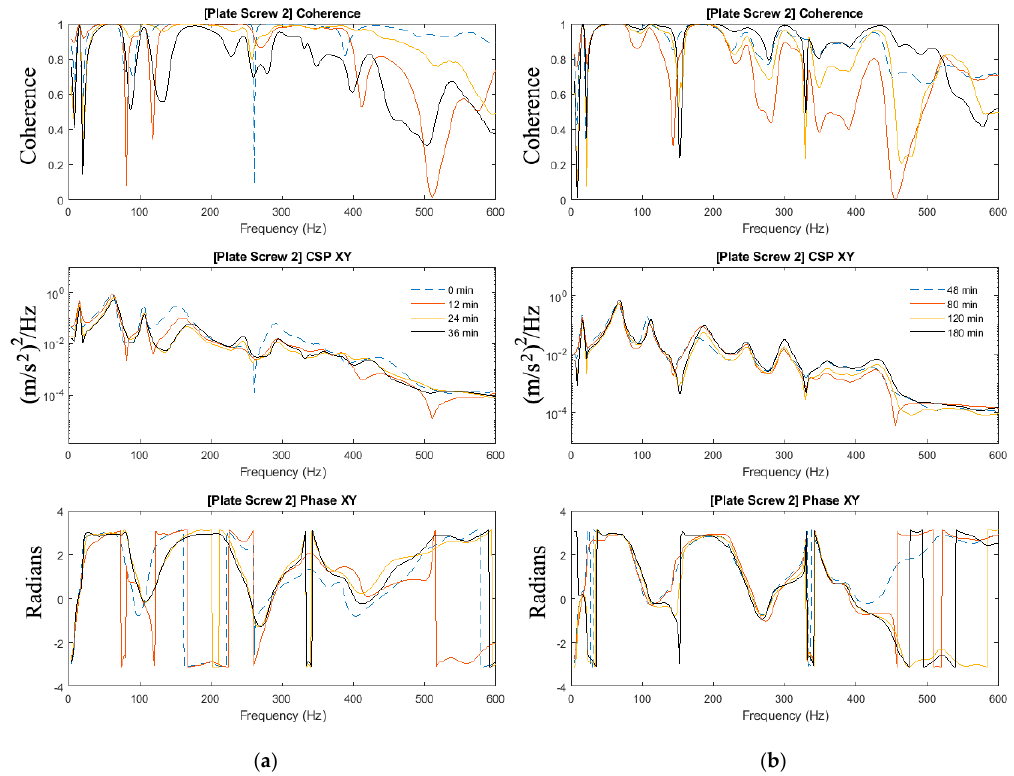
Figure 8. Coherence, cross-spectra and phase functions of Test #2 experimental investigations; ( a ) from 0 to 36 min and ( b ) from 48 to 180 min.